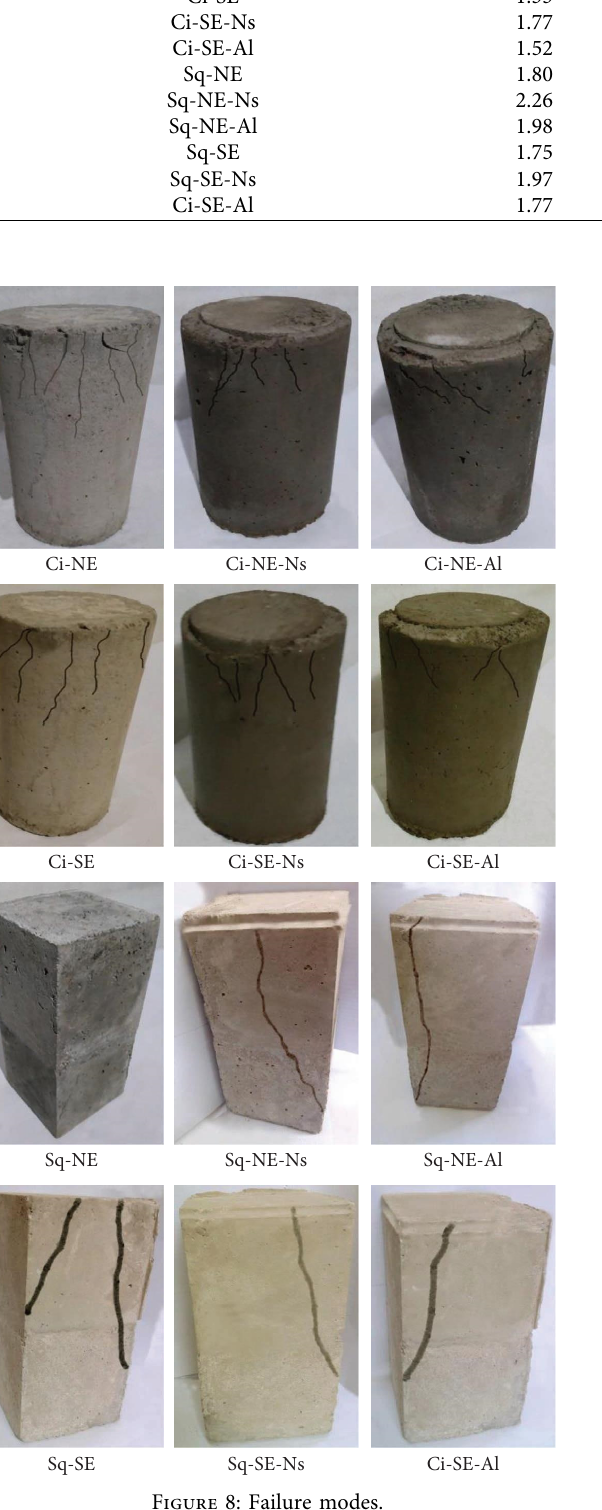
Figure 8: Failure